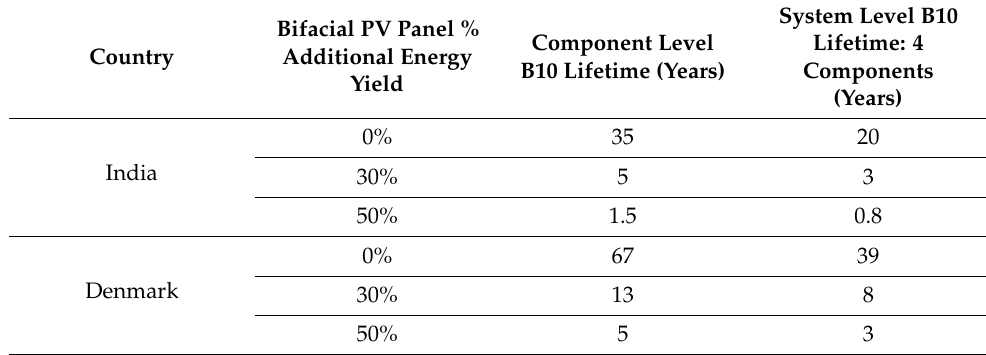
Table 6. B10 lifetimes of PV inverters considering bifacial PV panels.